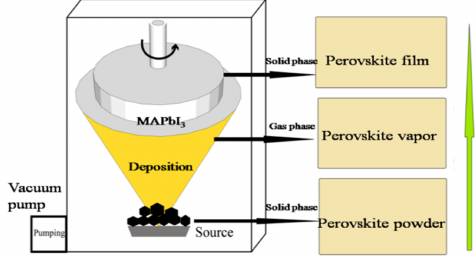
Figure 1. The simplified schematic diagram of the single-source thermal